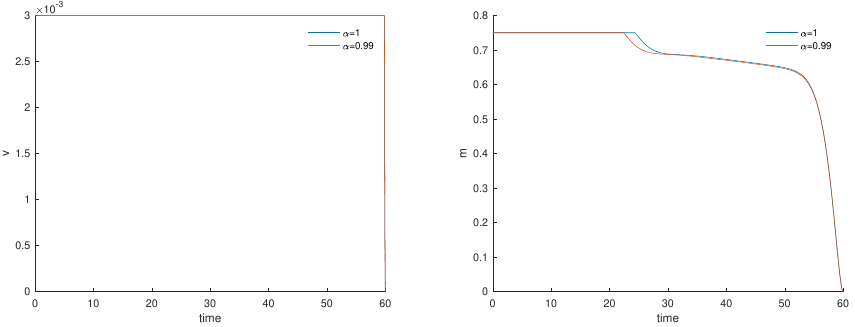
Figure 9. Pontryagin controls v (left) and m (right) for the FOCP (4)–(7) using the values in Table 1 and fractional order derivatives α = 1.0 and α = 0.99. The extremal controls v take their maximum value v max almost